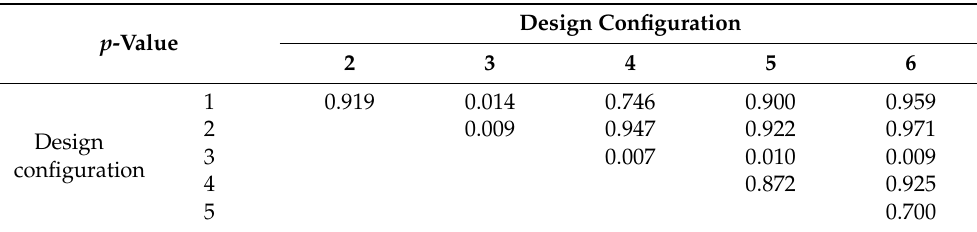
Table 4. Result of SNK post hoc analysis for the specific energy consumption depending on the design